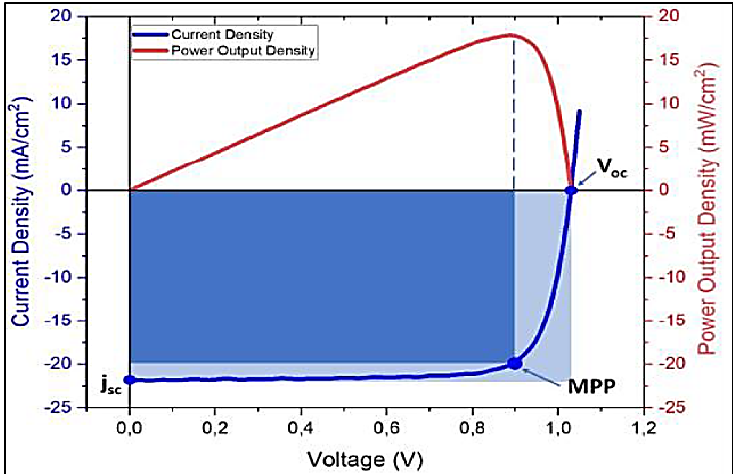
Figure 1: A solar cell's typical current density-voltage curve and matching electrical power output density. The current density (J) of the short-circuit, voltage (V and maximum power output point at (PMPP) are all denoted